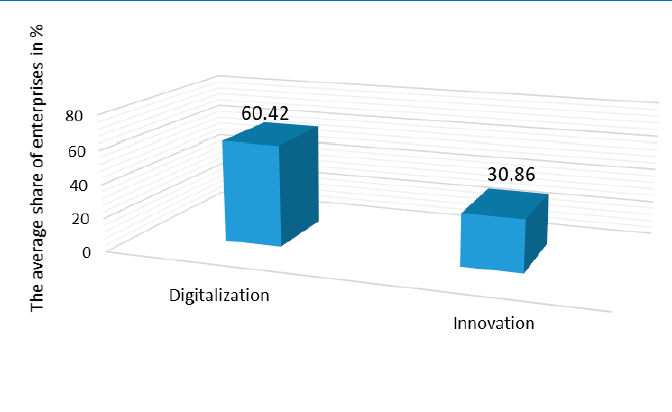
Figure 5. Average analysis of ICT and innovation in the steel industry (manufacturers of basic metals) in Poland. Source: Data from GUS [122].